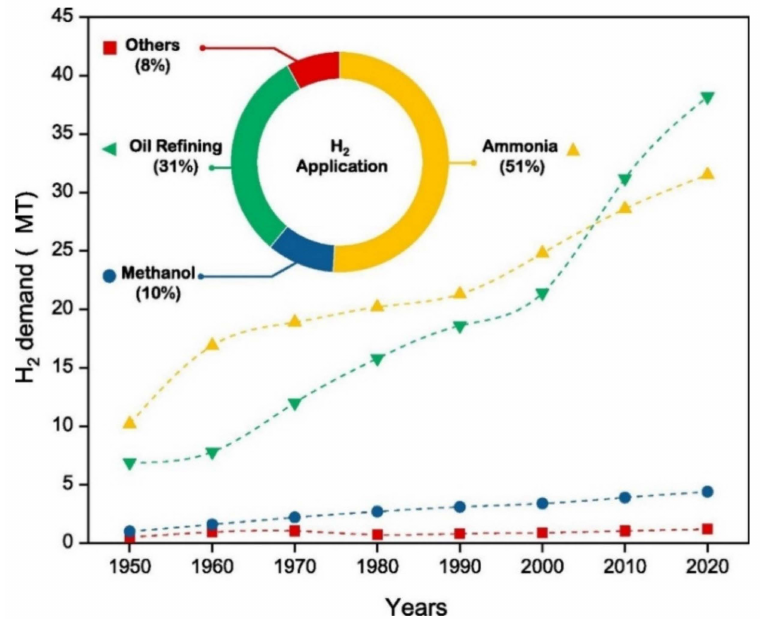
Figure 2. Demand of hydrogen worldwide and its share on various uses [35]. Reproduced with permission from Elsevier,